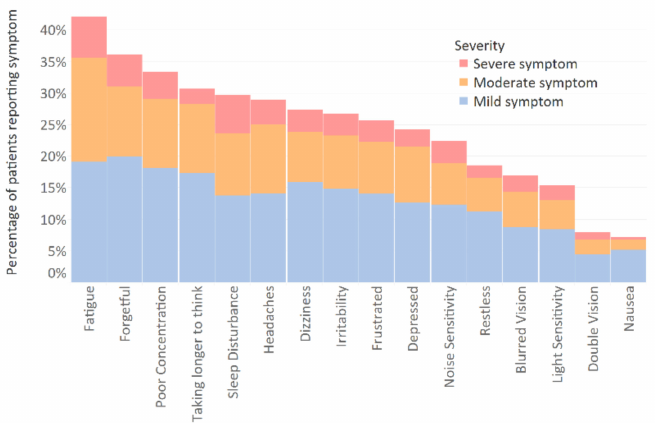
Figure A1. Frequency of post-concussion symptoms as measured by the RPQ 6 months